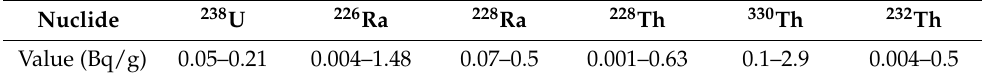
Table 1. Radioactive nuclides in